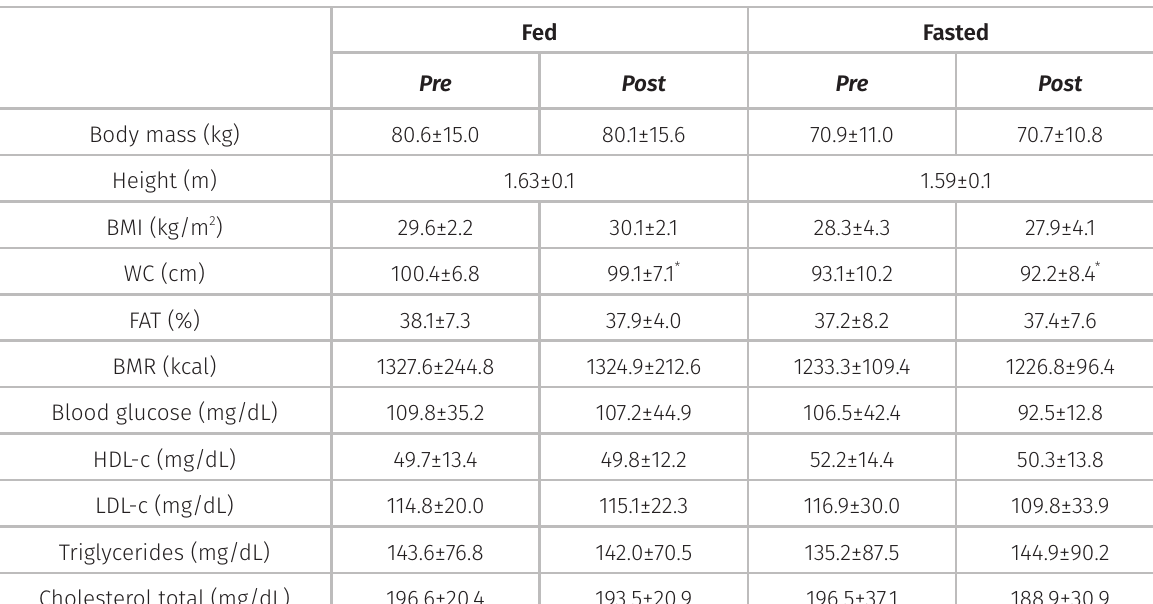
Table I. Anthropometric, body composition, and blood analysis characteristics between the fed and fasted conditions before and after the multicomponent training